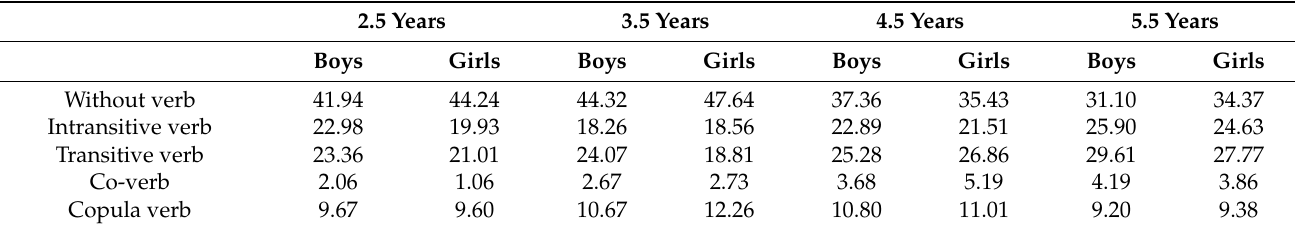
Table 6. Verb patterns by age and